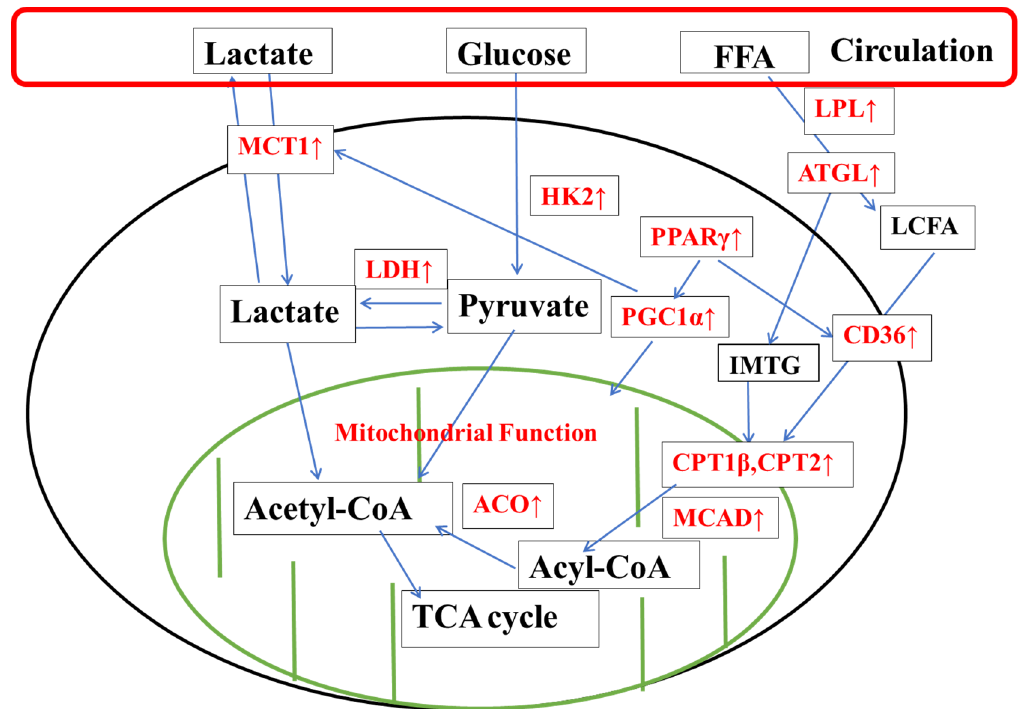
Figure 9. The suggested mechanisms by KPE administration enhance cell metabolism in soleus mus- cle. FFA, free fatty acids; LPL, lipoprotein lipase; ATGL, Adipose triglyceride lipase; MCT1, mono- carboxylate transporter 1; Hk2, hexokinase 2; LCFA, Fatty acids; PPAR γ , peroxisome proliferator- activated receptor gamma; LDH, lactate dehydrogenase; PGC1 α , peroxisome proliferator-activated receptor gamma coactivator 1-alpha; Cd36, CD36 molecule; IMTG, intramuscular triglycerides; CPT, carnitine palmitoyl transferase; Acetyl-CoA, acetyl coenzyme A; ACO, acyl-CoA oxidase; MCAD, acyl-Coenzyme A dehydrogenase medium chain; TCA cycle, tricarboxylic acid cycle. Ar- rows, significantly altered gene expression due to KPE administration.